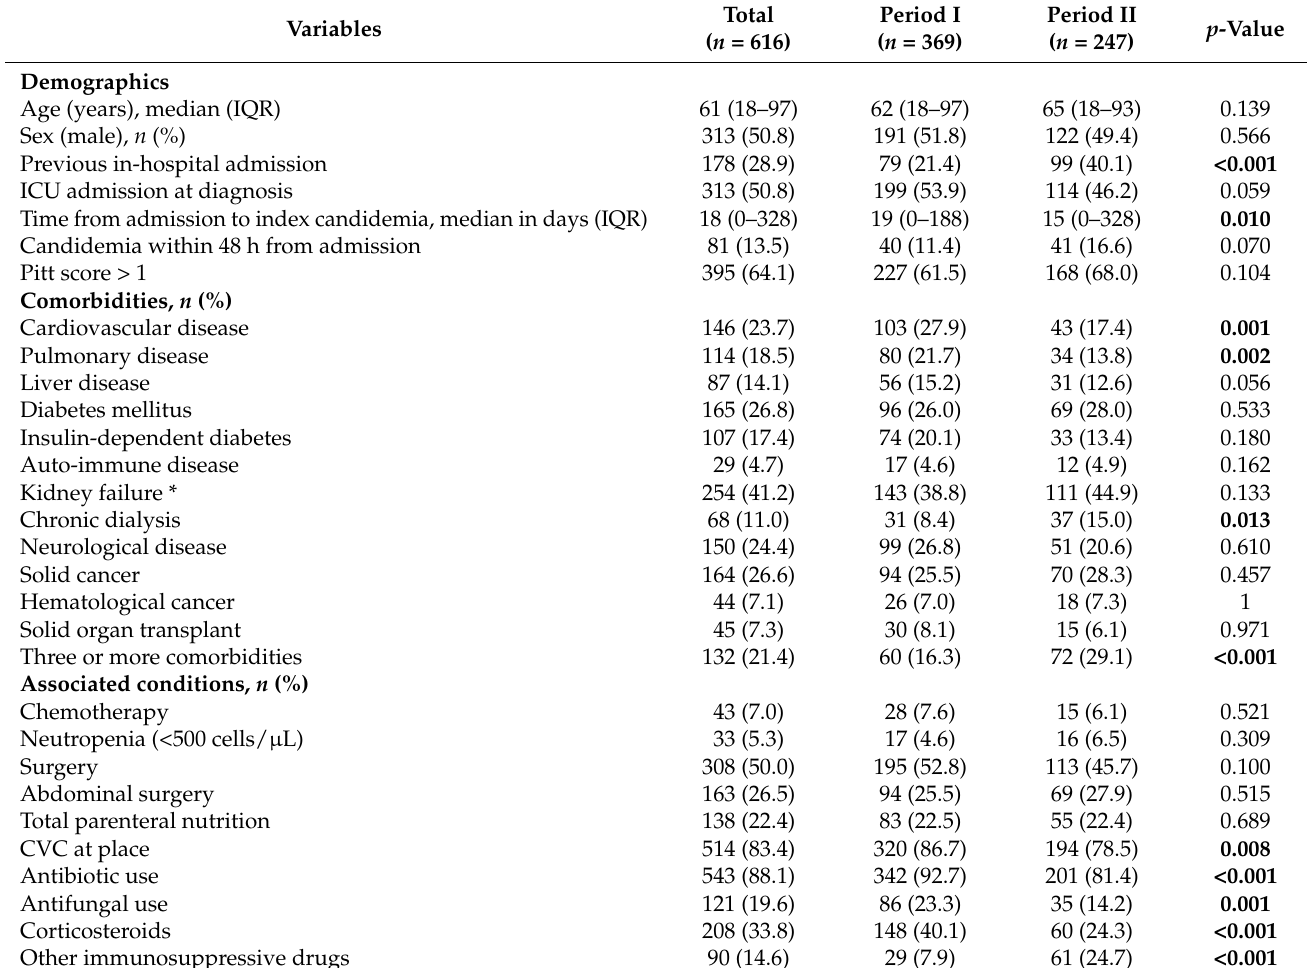
Table 1. Baseline characteristics of candidemic adults diagnosed at tertiary hospitals in Brazil during Period I: 2010–2011 vs. Period II: 2017–2018.